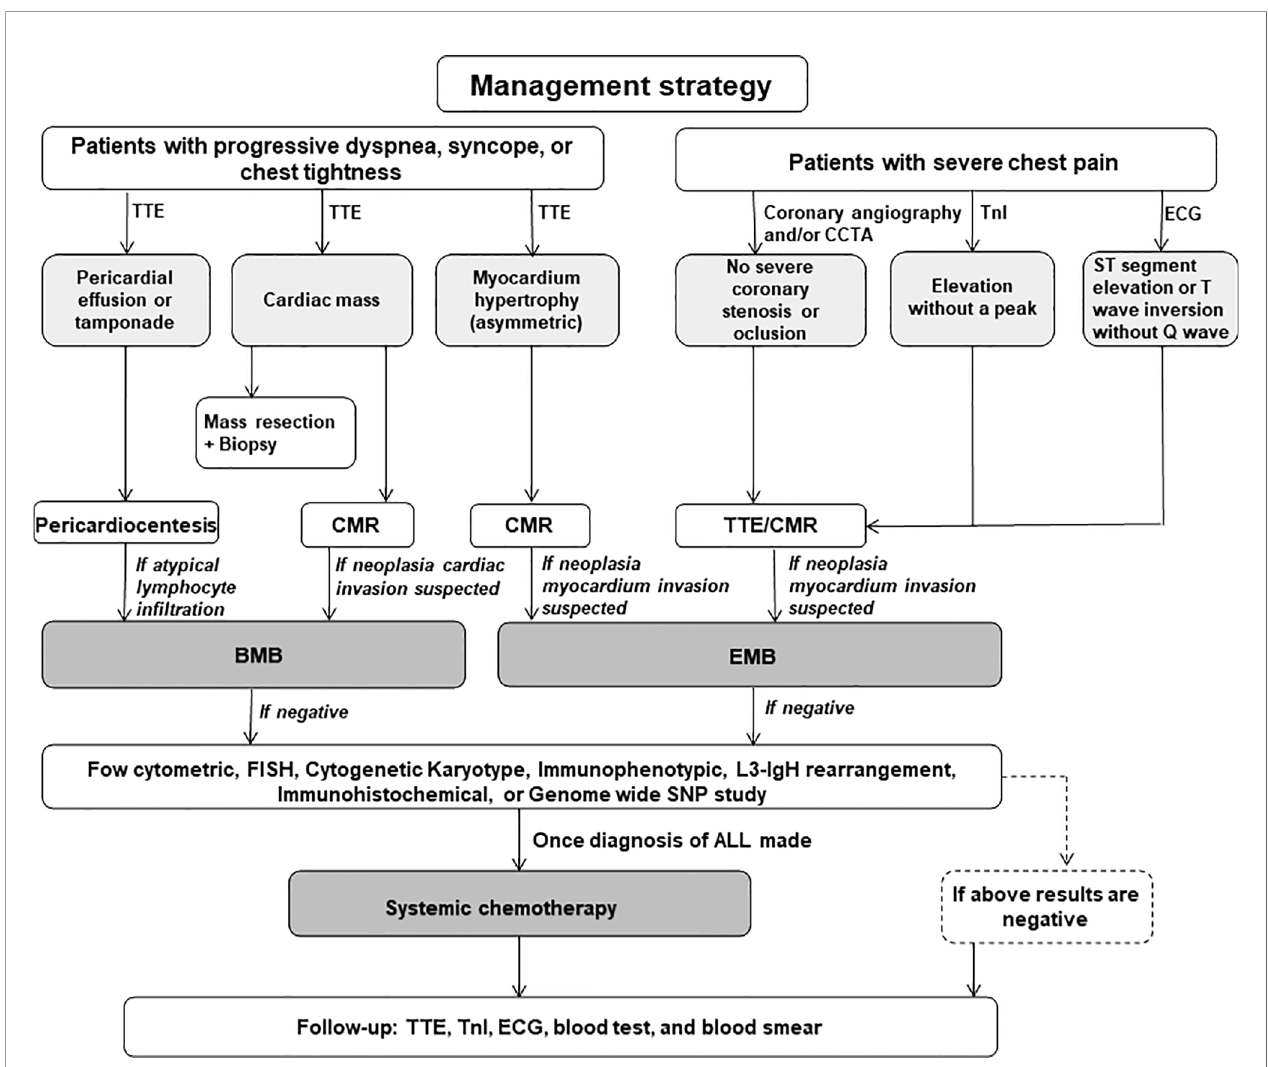
FIGURE 1 | The management recommendations for the acute lymphoblastic leukemia patients with cardiac problems as the fi rst manifestation. TTE, transthoracic echocardiography; CCTA, coronary computed tomography angiogram; TnI, troponin I; CMR, cardiac magnetic resonance; EMB, endomyocardium biopsy; FISH, fl uorescence in situ hybridization; SNP, single nucleotide polymorphism; ALL, acute lymphoblastic